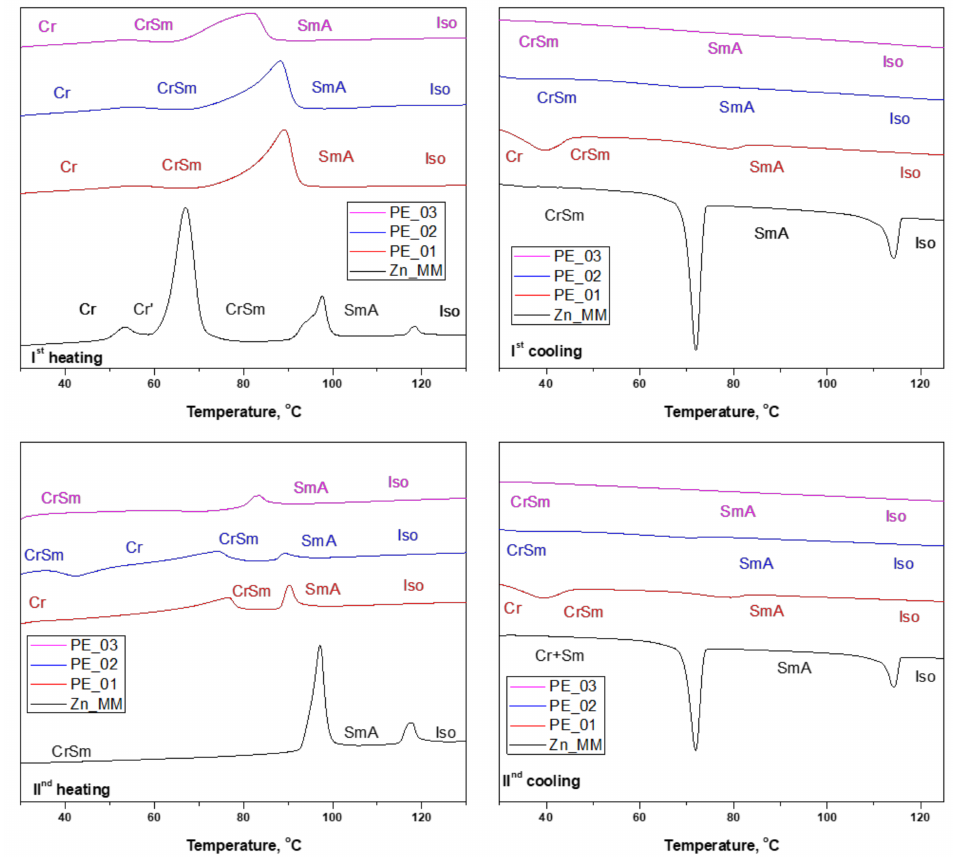
Figure 3. DSC thermograms of pristine complex Zn_MM and paste electrodes PE_0i (Top and bottom rows: 1st and 2nd heat/cool cycle,